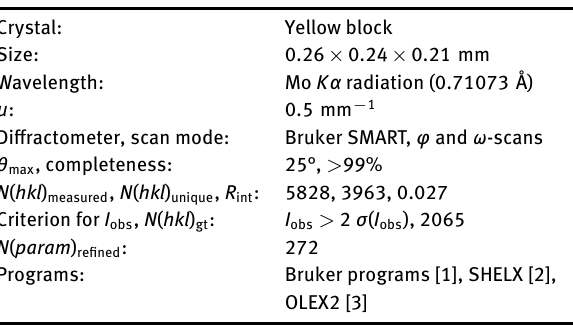
Table 1: Data collection and handling.